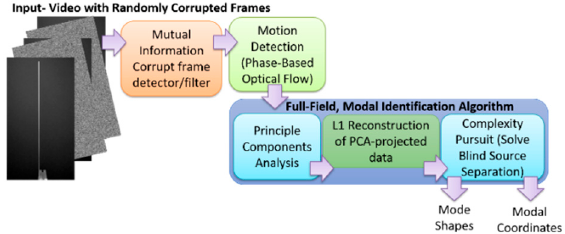
Figure 16. Algorithm for performing modal identification on video with randomly corrupted frames using L1 regularization.